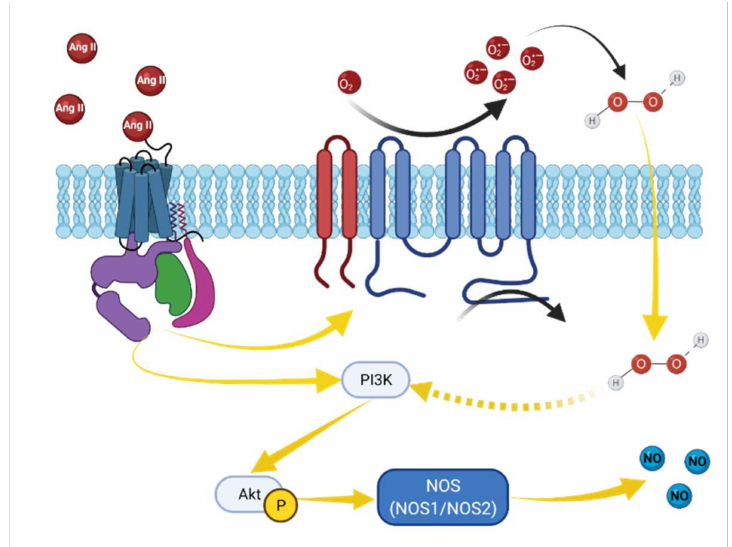
Figure 4. Proposed angiotensin II and H 2 O 2 -induced NO elevation in podocytes. Angiotensin-II metabolites may activate production of NO in cells through AT2R or Mas receptors [70,71]. Activation of this GPCR is followed by PI3-K/Akt-dependent NOS phosphorylation and subsequent NO production [71,72]. Angiotensin II binds to its receptors and activates NADPH oxidase, which in turn increases ROS generation. NADPH oxidases, such as NOX4, mediate H 2 O 2 release, which may further promote PI3-K/Akt-dependent NOS phosphorylation and subsequent NO production